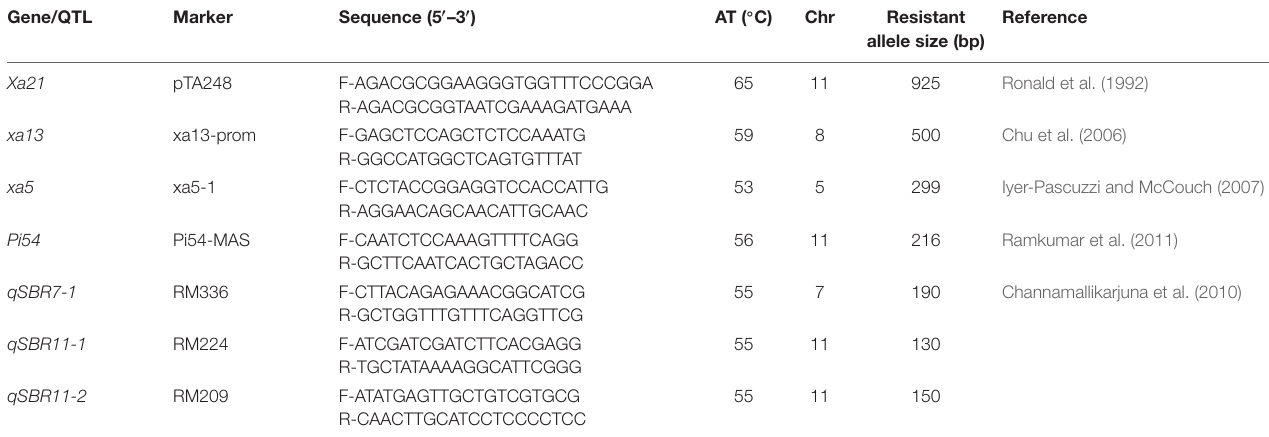
TABLE 1 | Details of molecular markers used for foreground selection.